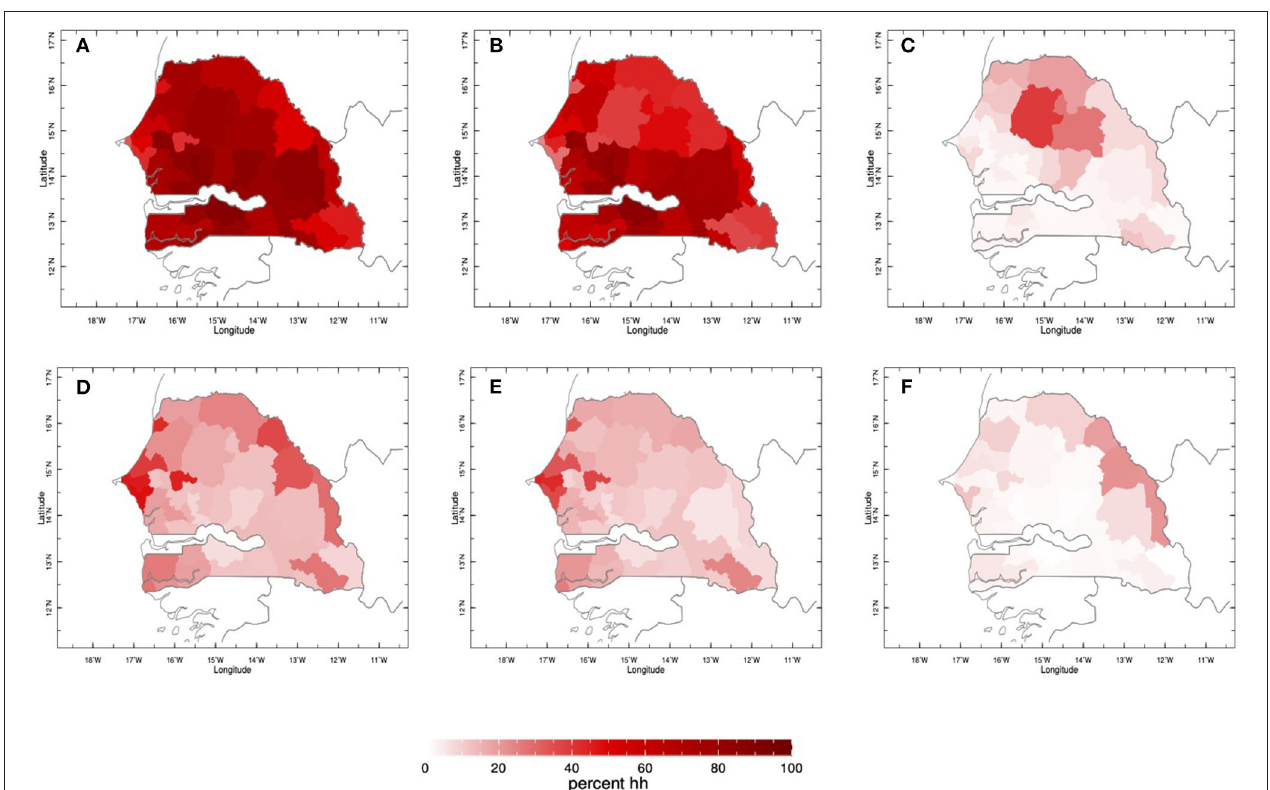
FIGURE 8 | Spatial distribution of the dominant source of income at household level, across departments, averaged over the three surveys taken in 2013, 2014, and 2016. The top row depicts the percent of households by department whose primary source of income is climate sensitive [ (A) is the sum of agriculture, livestock raising, fishing, and hunting and gathering, (B) is agriculture only, and (C) is livestock raising only]. The bottom row depicts the percent of households by department whose primary source of income is not climate-sensitive [ (D) is the sum of salaried and self-employed activities and remittances, (E) is salaried and self-employed activities, and (F) is remittances